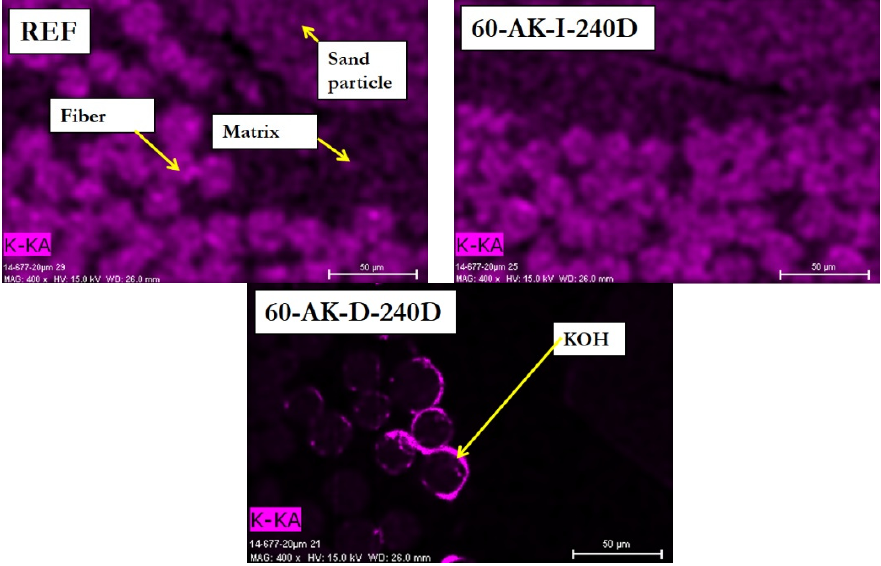
Figure 10. EDX mapping of K over cross-sections of the reference and aged GFRP rebars, at locations close to the external sand coating layer.